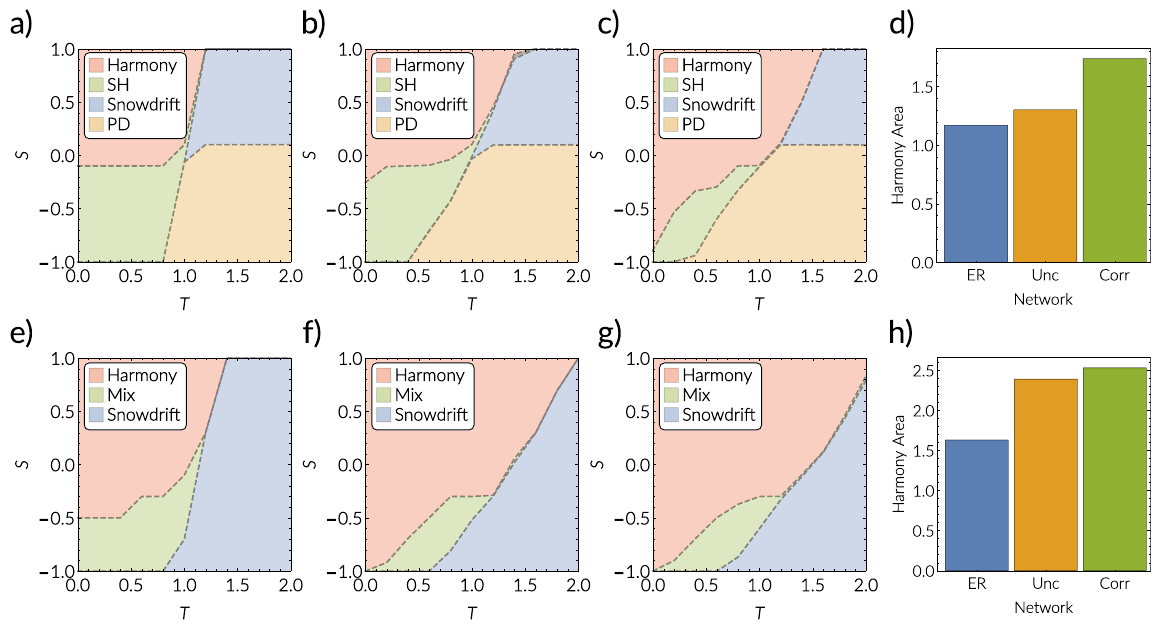
Figure 3. Approximated phase diagrams (see Supplementary Materials) from numerical simulations for γ = 0.2 and β = 0.5 ( a – d ) as well as β = 0.7 ( e – h ). ( a ) Erdős Rényi network with mean degree 〈 k 〉 = 6 and N = 10000. ( b ) Using GMM multiplexes with N = 10000 nodes, mean degree 〈 k 〉 ≈ 6, a power-law exponent 2.9 and temperature T GMM = 0.4. Layers are uncorrelated, i.e. g = v = 0. ( c ) same as ( b ) but with geometric correlation, in particular g = v = 1. ( d ) shows the size of the “harmony” area in the phasespace for different parameters, i.e. the size of the red area in ( a – c ). The blue bar is for the Erdős Rényi networks as shown in ( a ), the yellow bar represent the GMM model without correlations as shown in ( b ), and the green bar denotes the GMM model with correlations as presented in ( c ). (e – h) shows the same as ( a – d ) but for β =